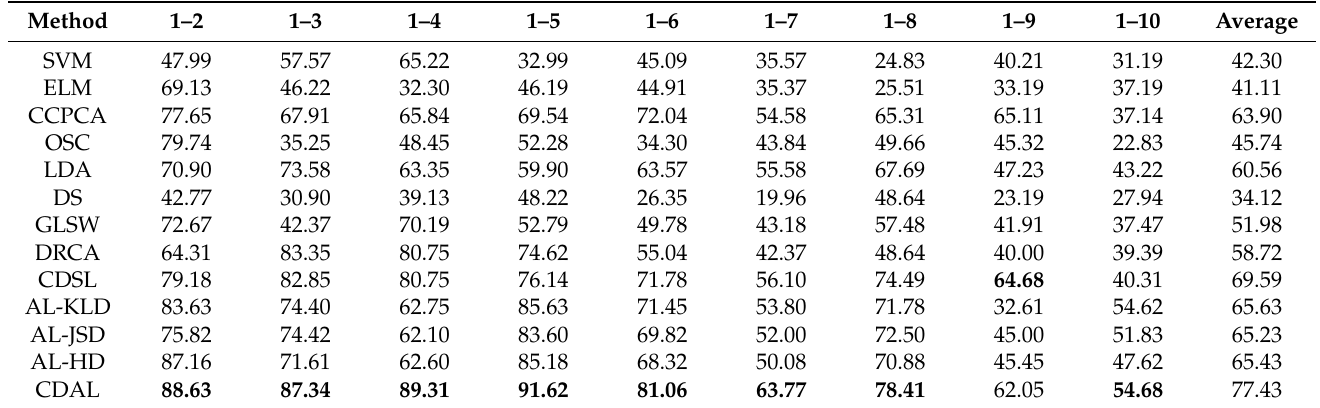
Table 2. Comparison of recognition accuracy in long-term drift (%).